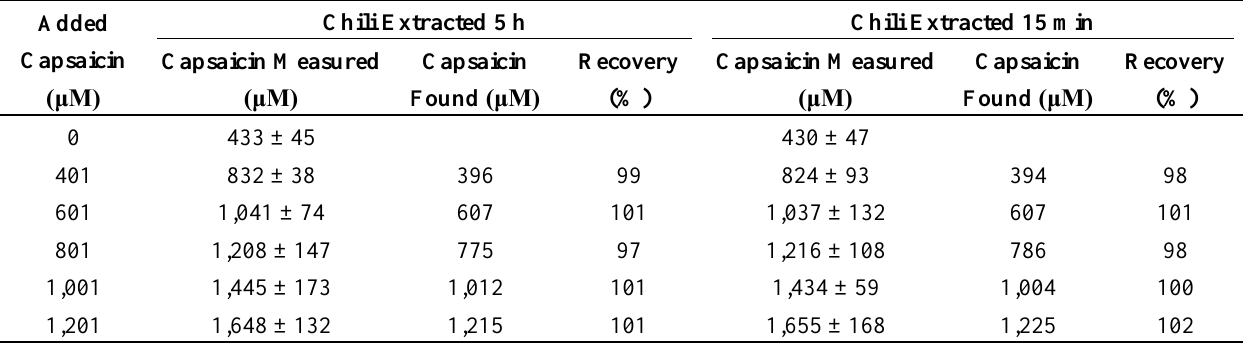
Table 1. The recovery of spiked capsaicin determined in chili samples using biosensor.